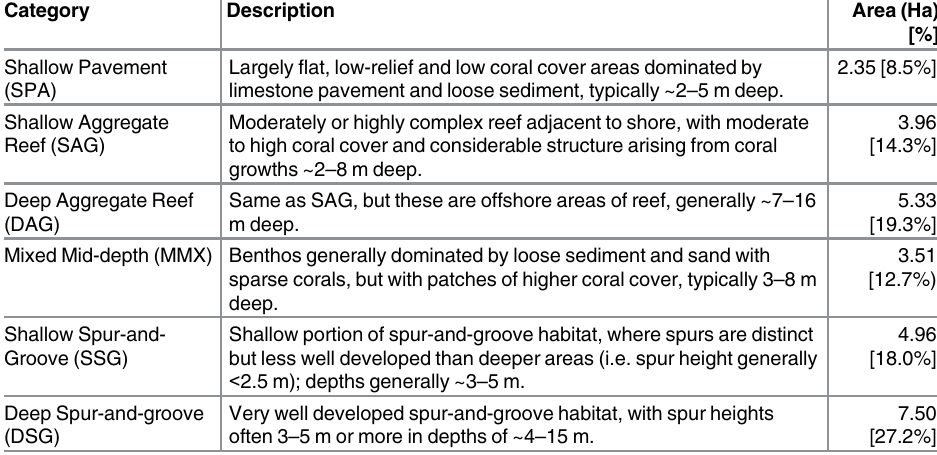
Table 1. Habitat-strata classification and proportional